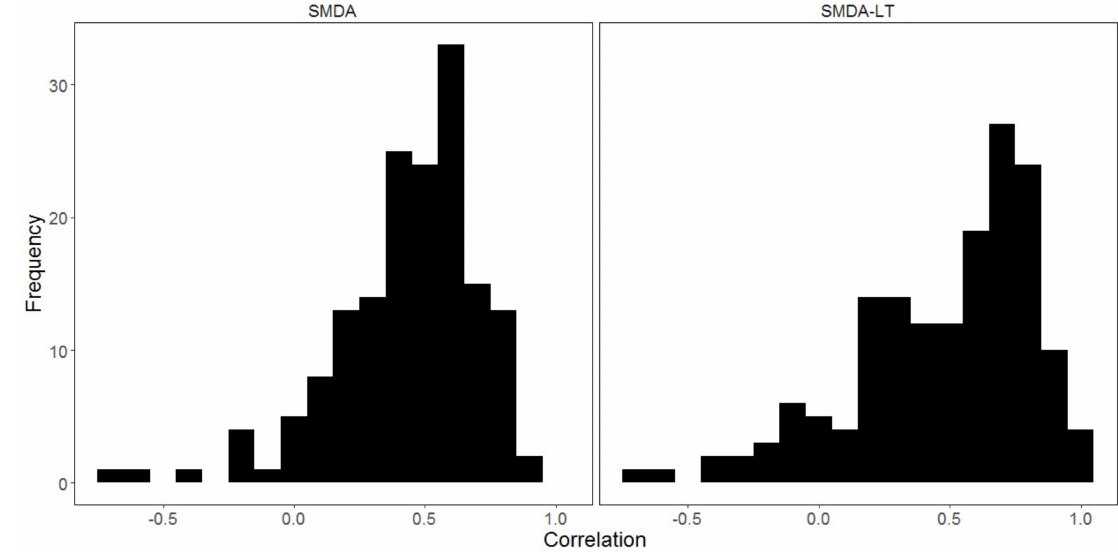
Figure 9. Comparison of PDSI modelled from station data to Soil moisture difference from average with an added “memory” term (SMDA-LT) from blended SMAP-SMOS time series. Trend line represents a linear correlation of 0.27, significant at p < 0.001.